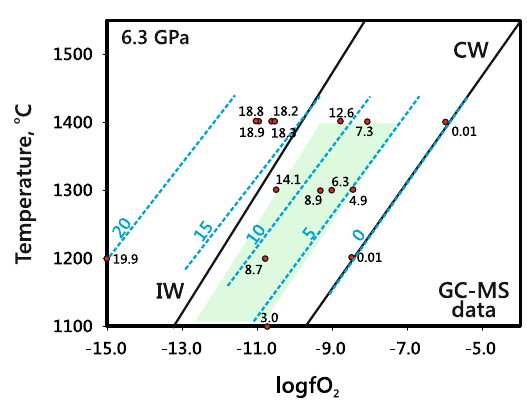
Figure 10. Concentrations of carbon (mole %) in reduced C-O-H-N fluids at 6.3 GPa, according to GC-MS analysis. Red circles are GC-MS-measured values for experimental compositions; blue dash line is the carbon isopleth. Light-green field shows T- f O 2 range for cratonic lithospheric mantle at a depth of ~200 km (see text for explanation). IW and CW curves are after refs 1, 24 and